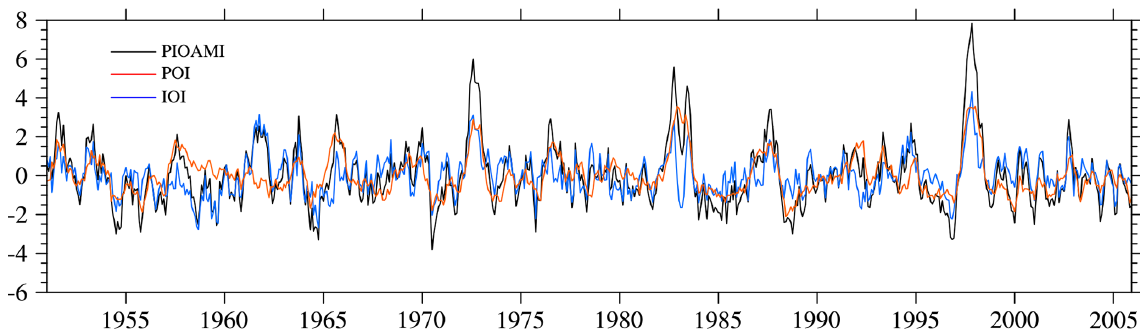
Figure 8. Time series of the PIOAM index (black), Pacific Ocean index (red) and Indian Ocean index (blue) in the HadISST